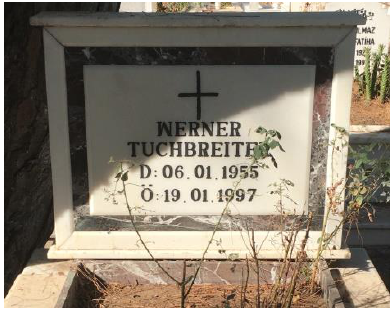
Figure 4. Showing a gravestone of a Christ